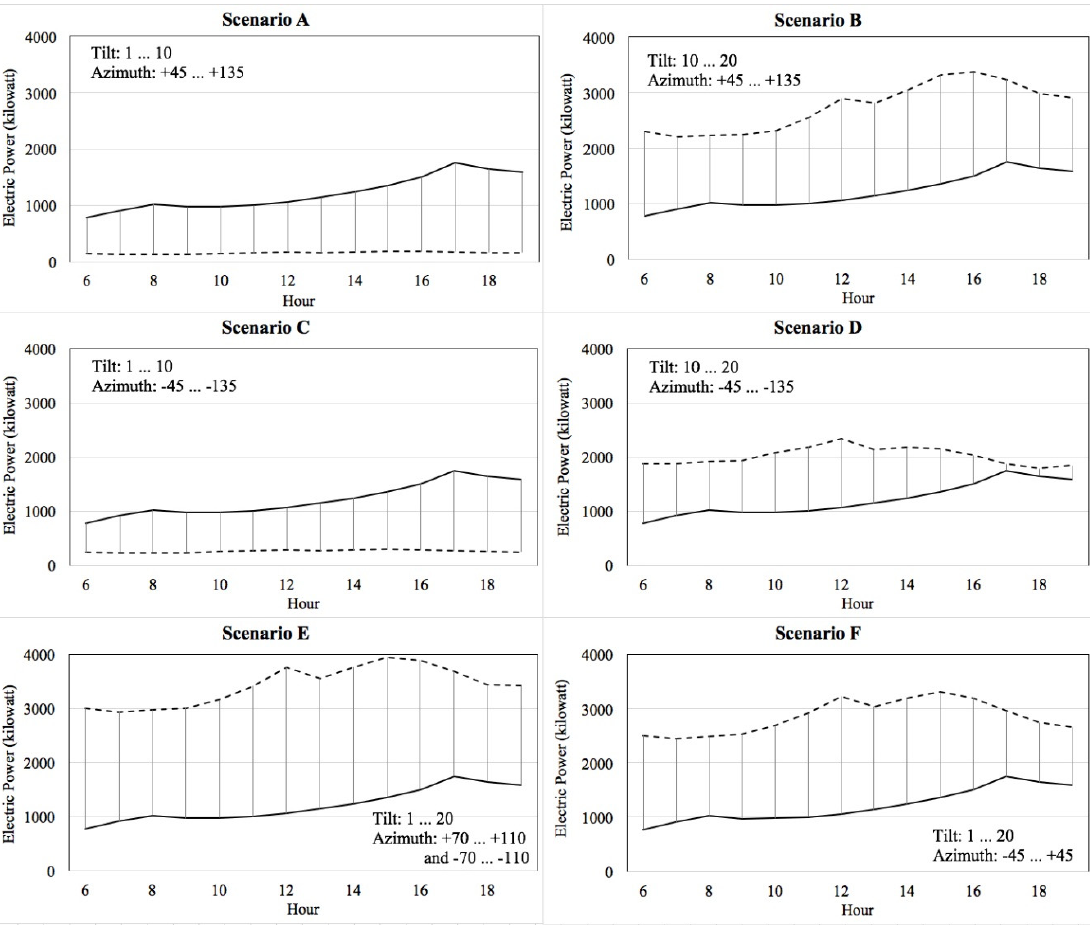
Figure 13. Residential Total Load (solid line) and Distributed Solar Plant Generation (dashed line) for 6 scenarios on 21 July. Table 2. Net load capacity support factors for 6 selected scenarios and 4 selected